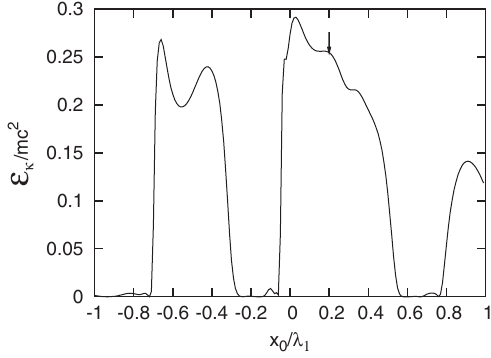
FIG. 1. The final scaled kinetic energy versus the initial posi- in units of wavelength (cid:2) tion of the ion x 0 position of the target